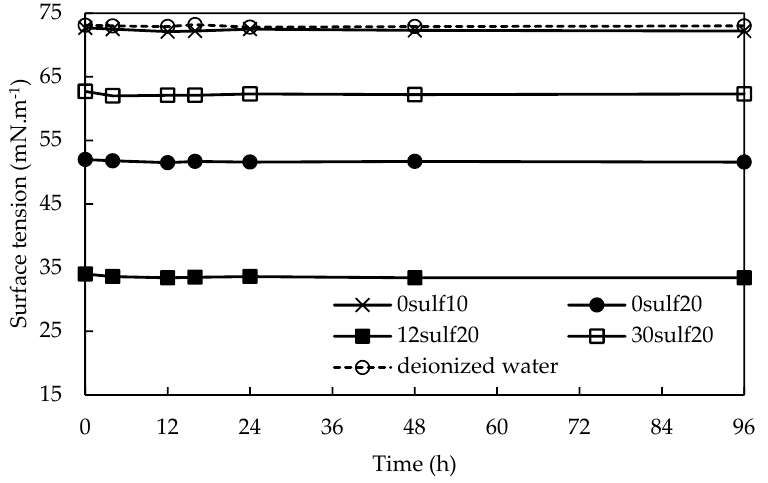
Figure 11. Surface tension behavior over the time for systems containing 0.1 ( m / v ) %. Measurements were performed using the Wilhem plate method (temperature: 25 ± 0.5 °C).